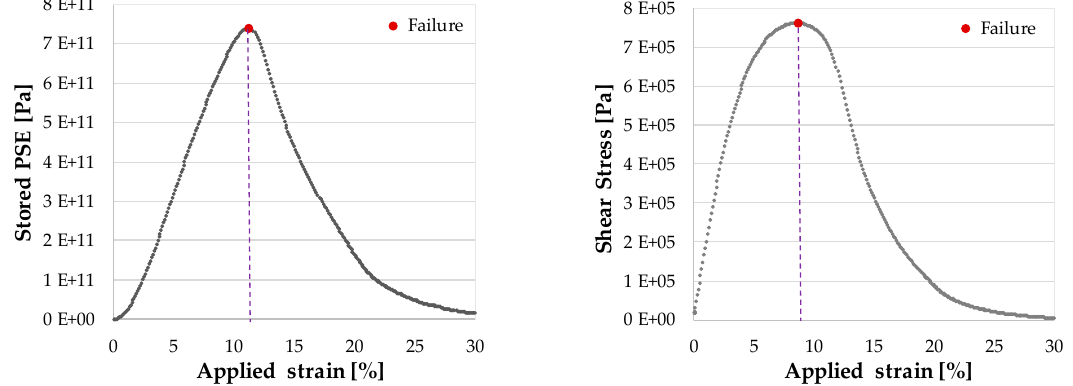
Figure 11. Results of Linear Amplitude Sweep (LAS) tests—identification of failure conditions: ( a ) at maximum stored pseudo-strain energy density; ( b ) at maximum shear stress.